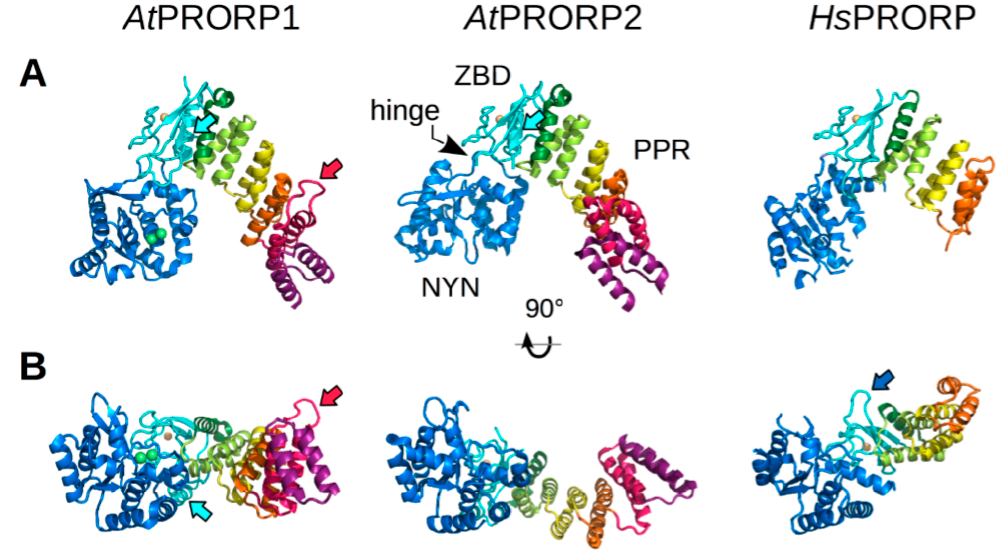
Figure 1. Protein-only RNase P (PRORP) architecture. As of May 2016 nine crystal structures of PRORP enzymes are available in the Protein Data Bank, four for Arabidopsis PRORP1 in the presence of different metal ions (PDB IDs: 4G24, 4G25, 4G26), two for PRORP2 (5DIZ, 5TF9) and three for truncated forms of human PRORP lacking PPR1-4 or PPR1-2 modules (4ROU, 4XGL, 4XGM). Selected structures correspond to At PRORP1 with two bound manganese ions shown in green (4G24, 1.95 Å resolution, [19]), and highest resolution models of At PRORP2 (5FT9, 3.05 Å resolution, Pinker et al. in preparation) and of Hs PRORP (4XGL, 1.8 Å resolution, [36]). All PRORP enzymes contain an N-terminal pentatricopeptide repeat (PPR) domain made of five PPR modules (PPR 1-5 depicted in violet, red, orange, yellow, and green, respectively) followed by a single helix (half PPR or PPR5B, shown in dark green), and a C-terminal N4BP1, YacP-like Nuclease (NYN) catalytic domain (NYN, depicted in dark blue). These two functional domains are linked by a bipartite zinc binding domain (ZBD, depicted in cyan) coordinating a Zn 2+ ion (shown in gold). PRORP structures are either superimposed according to their PPR3-5B modules and ZBD ( A ) or to their catalytic domain ( B ). These two orthogonal views highlight the possible reorientation of PPR and NYN domains with respect to each other, owing to a flexible hinge present between the NYN and ZBD. Red, cyan, and blue arrows indicate the long loop of PPR2 motif present in At PRORP1, the 30-residue-long linker inserted in the ZBD next to the PPR domain in Arabidopsis enzymes, and the extended lariat loop in the central region of human PRORP, respectively. Molecular representations of PRORPs were prepared with PyMOL (Schrödinger, Portland, OR, USA).